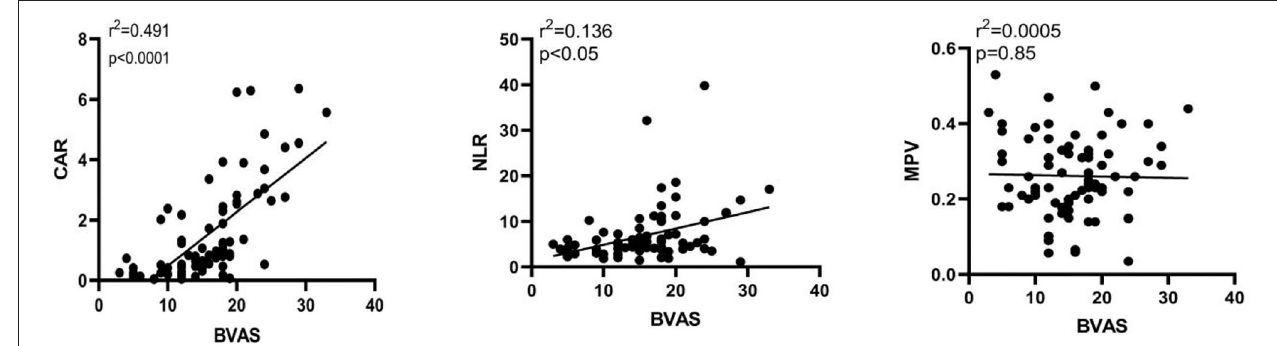
FIGURE 2 | Correlation between CAR, NLR, and MPV levels and disease activity in AAV patients. Spearman correlation analysis was conducted to test the relationship between the CAR, NLR, and MPV and disease activity. The CAR and NLR were found to be positively correlated with disease activity, while MPV did not show a significant correlation with disease activity. CAR, C-reactive protein/albumin ratio; NLR, neutrophil/lymphocyte ratio; MPV, mean platelet volume; BVAS, Birmingham Vasculitis Activity Score.